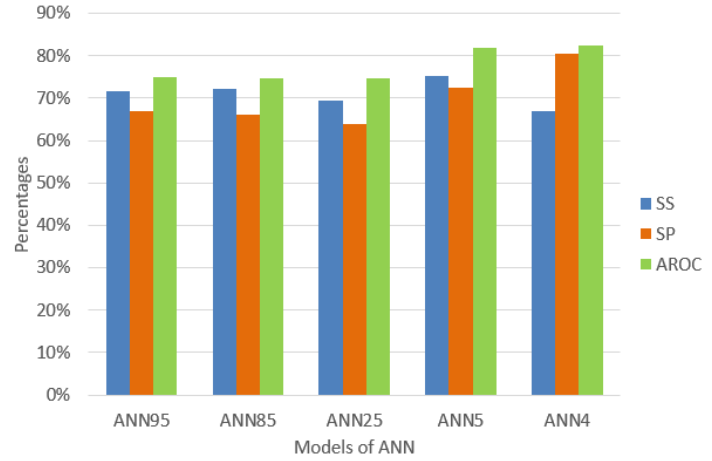
Figure 4. Percentage of the performance indicators of the models of